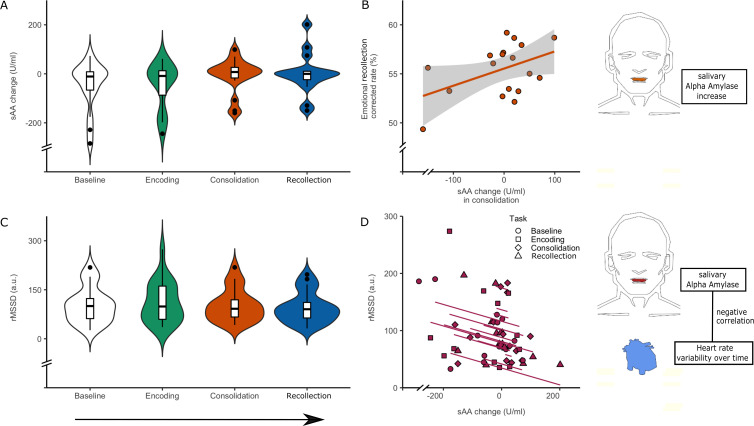
Associations between autonomic tone measures and memory performance across the task stages.(A) sAA change during the task (encoding, consolidation and recollection) relative to the baseline resting-state. A significant increase in sAA was observed between consolidation and baseline (linear mixed effects model, p=0.033, N = 21, 68 observations). (B) Association between ΔsAA (consolidation – baseline) and emotional memory performance (correlation, r = 0.452; p=0.059, N = 18). (C) Distributions of the rMSSD during the task (encoding, consolidation and recollection) relative to the baseline resting-state (no significant differences, linear mixed effects model, p=0.23, N = 18, 63 observations). (D) Repeated measures correlation plot between ΔsAA and rMSSD across all task stages (Rrm = −0.387; p=0.018, N = 17, 56 observations). Boxplots inside the violinplots show median, quartiles (boxes) and range (whiskers). Shaded region in the scatterplot depicts the 95% confidence interval.Figure 3—source data 1.Autonomic tone and memory performance across the entire paradigm.Individual ΔsAA, rMSSD values per task stage. The emotional memory scores provided for panel B show the proportion of adjusted emotional scores versus neutral scores as indicated in the methods.